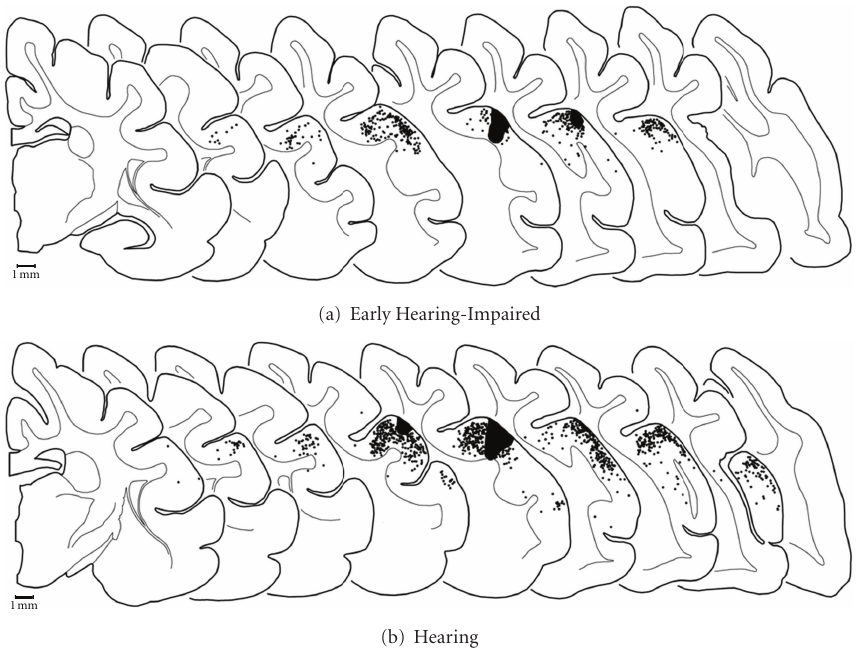
Figure 8: Sources of cortical inputs to core auditory cortices for early hearing-impaired (a) and normal hearing (b) ferrets. On serially arranged (anterior = left) coronal sections through one cortical hemisphere, tracer injection (BDA; solid black area) into core auditory cortex produced retrogradely labeled neurons (1 dot = 1 neuron) primarily within the regions regarded as auditory cortex: on the middle ectosylvian gyrus (MEG) and the posterior aspect of the anterior ectosylvian gyrus (AEG), as well as within the lateral bank of the suprasylvian sulcus (SSS) and into the bank of the pseudosylvian sulcus (PSS). The distribution of labeled neurons is essentially coextensive for hearing-impaired and hearing animals, with no di ff erence in labeling found within somatosensory regions on the suprasylvian (SSG) and anterior ectosylvian gyri. Hearing controls replotted from